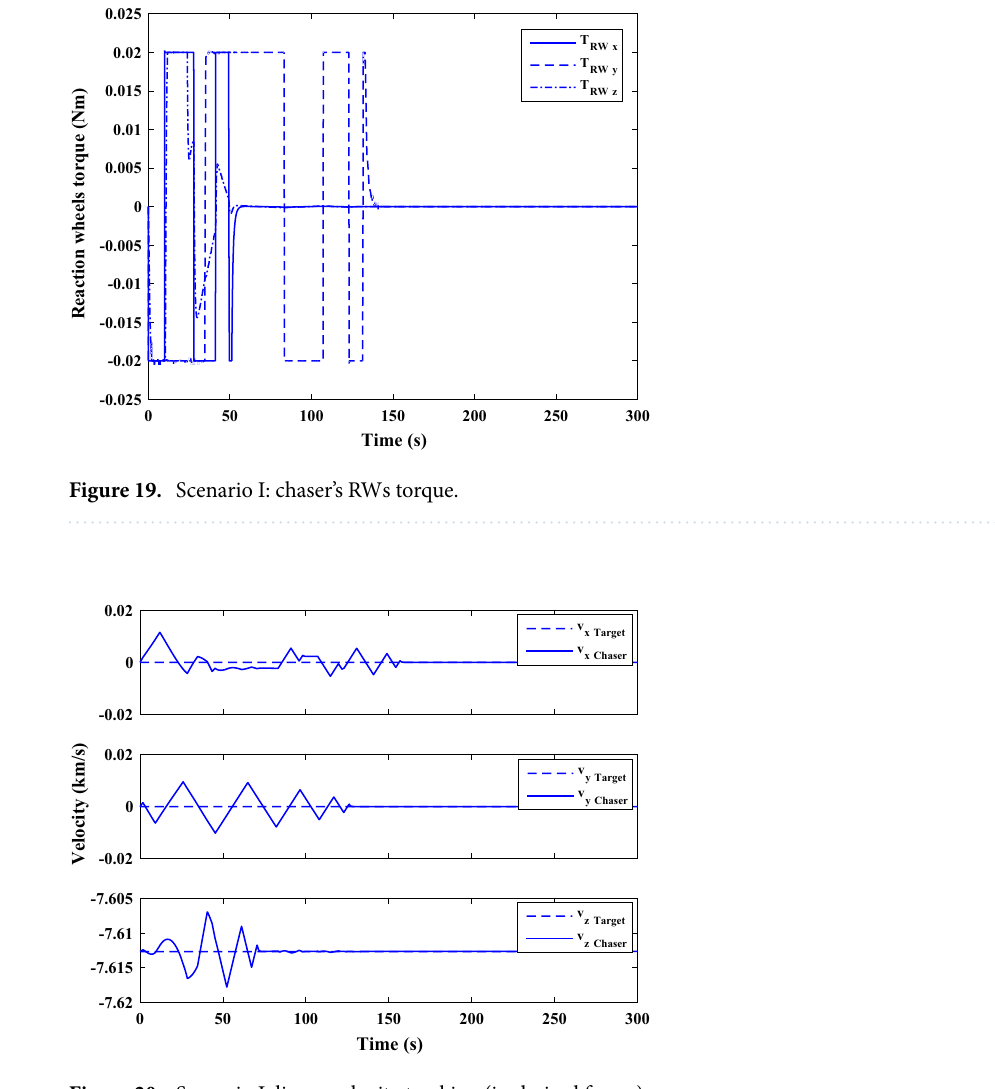
Figure 20. Scenario I: linear velocity tracking (in desired frame).